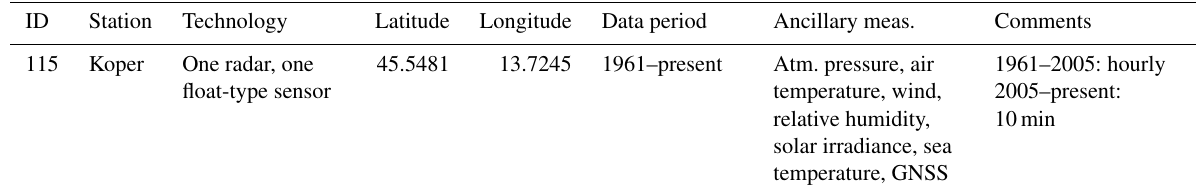
Table A11. Slovenian tide gauge station operated by the Slovenian Environment Agency. Data available at http://www.arso.gov.si/vode/ podatki/amp/H9350_g_1.html (last access: 18 June